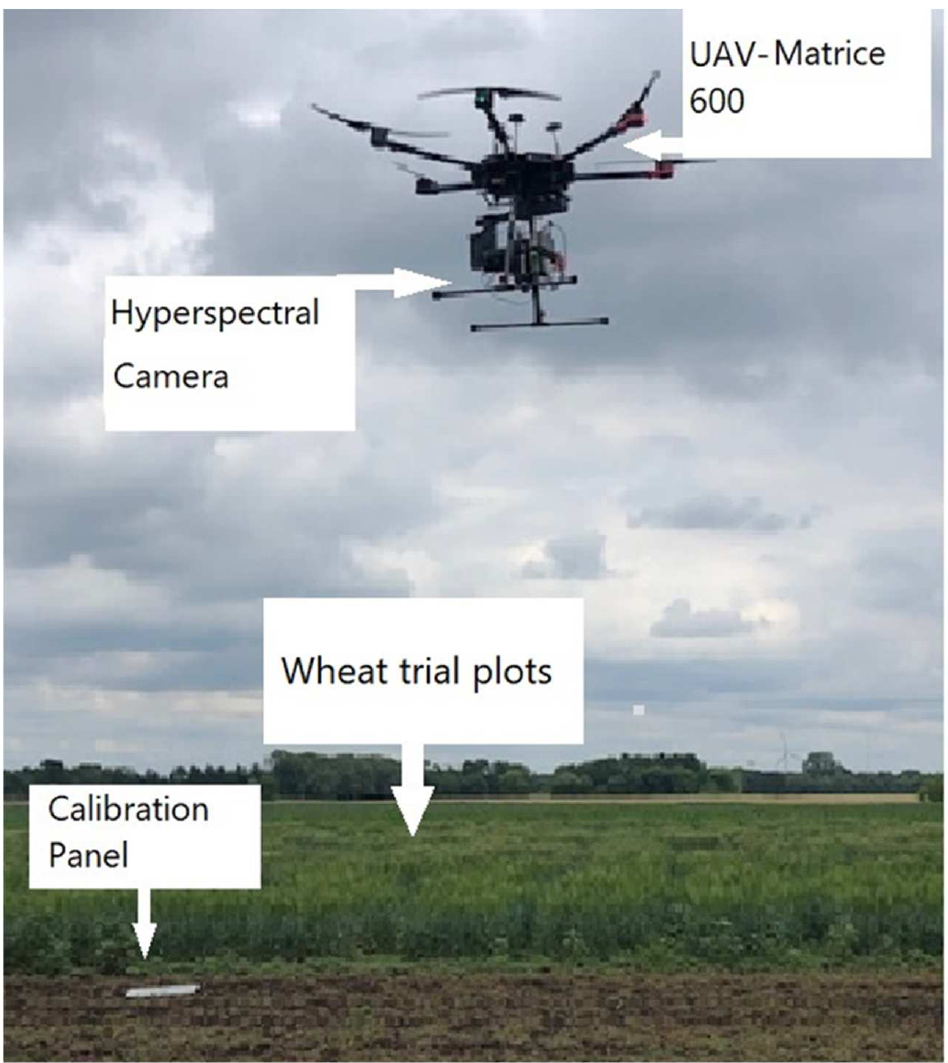
Figure 2. Unmanned aerial vehicle in the wheat field and calibration panels.